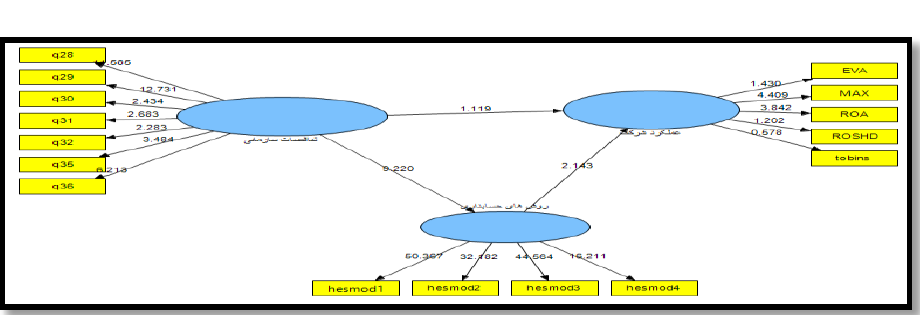
Figure 8. t-statistic for studying the significance of path coefficient